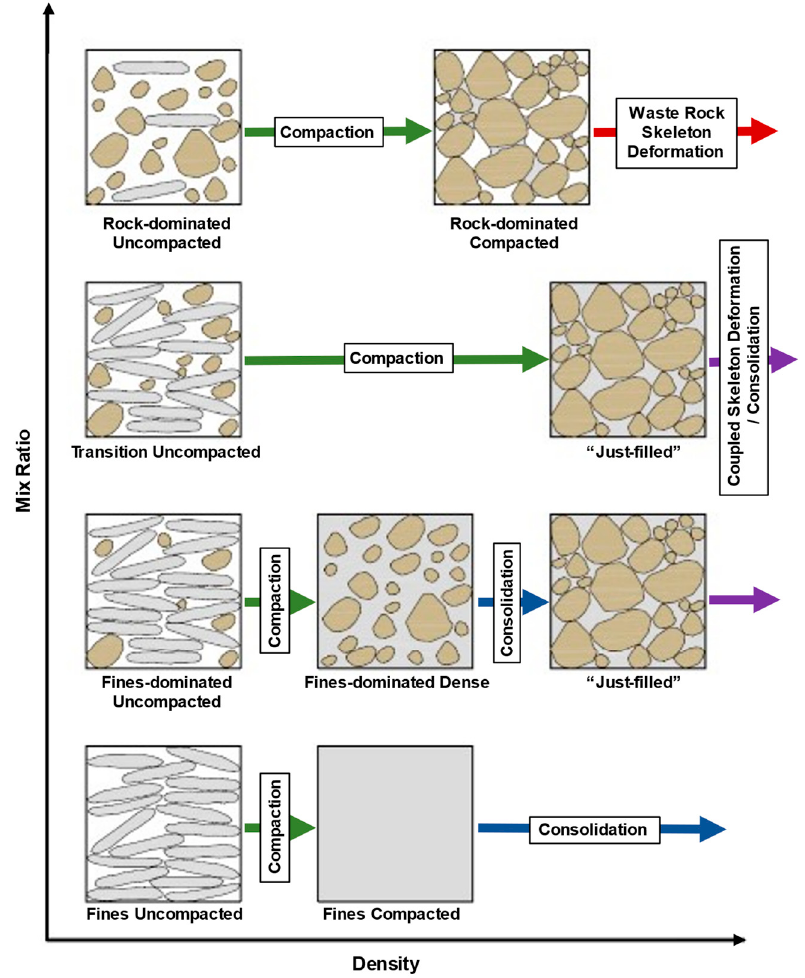
Figure 8. Structure and compression behavior of filtered tailings – waste rock blends.